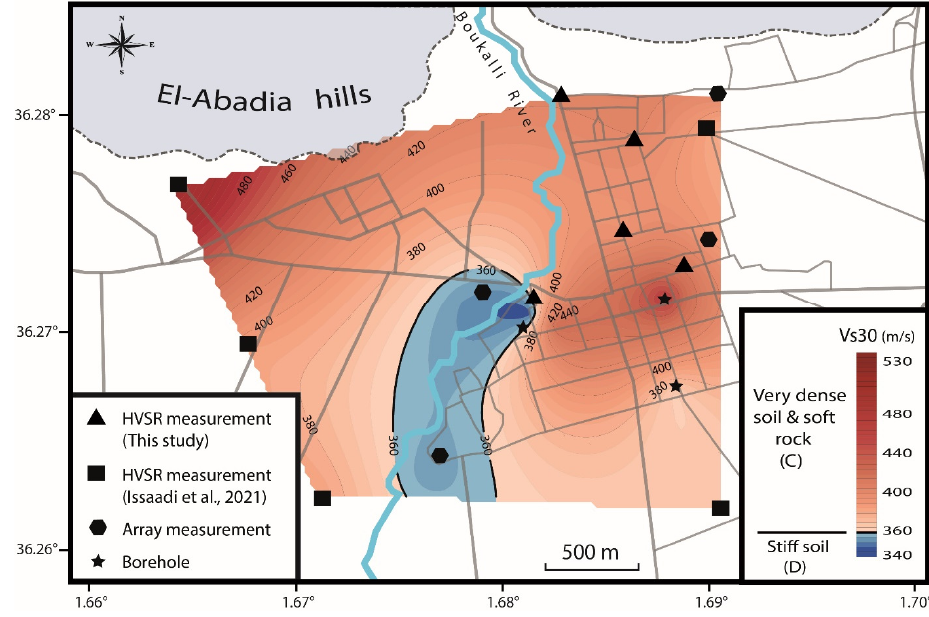
Figure 9. V (cid:2929)(cid:2871)(cid:2868) map and soil classification in the El ‐ Abadia city. Figure 9. V s30 map and soil classification in the El-Abadia city 4.5. V s30 Predictive Equation for the Middle ‐ Chelif Basin